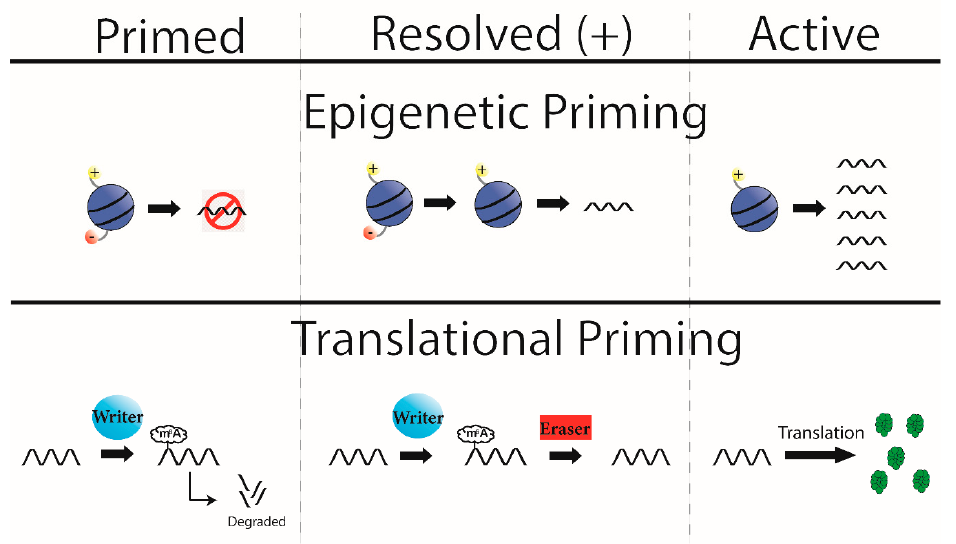
Figure 2. Epigenetic and Translational Priming. Bivalent histones (top) are a mechanism of epigenetic priming where a locus contains both a positive and negative transcriptional mark (left, top). At baseline this yields no or low levels of transcription, but if the appropriate signal is sensed, the bivalent domain is resolved (middle, top) here in the positive direction. This allows future stimuli to promote transcription from this locus, in a more rapid way than if it did not start with bivalent histones (right, top). Here we propose a model of translational priming that follows the same flow as epigenetic priming. Initially a transcript is primed (left, bottom), where a transcript is produced before it is needed for translation but is marked by m6A to degrade the transcript. This can be resolved by the appropriate stimuli, which removes the m6A mark (middle, bottom). The transcript can now be translated without first needing to start transcription.